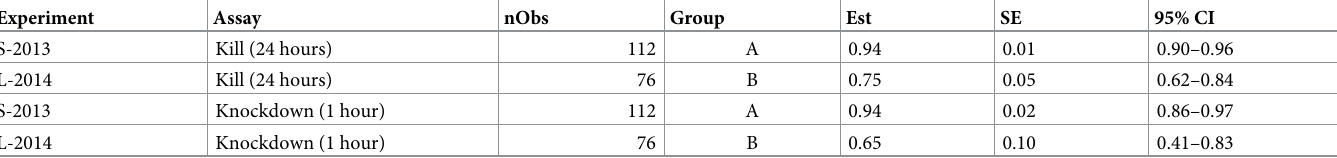
Table 2. Generalized linear mixed model (L-GLMM) results: Ae . aegypti control cage mortality and knockdown.